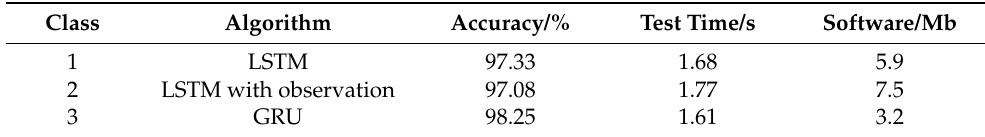
Table 6. Simulation results of the three LSTM methods.